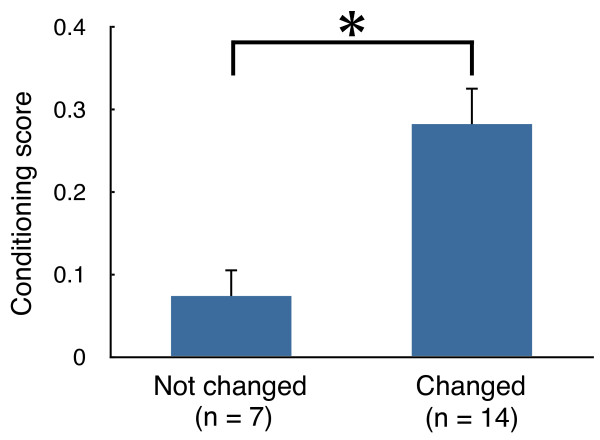
Comparison of the conditioning scores between fish with different PC responses to the CS. Conditioning scores (mean + SEM) for the fish with PCs that showed conditioning-related changes in response to the CS were greater than the scores in the fish with PCs that did not show conditioning-related changes in the response to the CS. Conditioning scores were calculated by averaging the conditioned responses in the last ten trials of the acquisition sessions. * denotes a significant difference (Mann-Whitney U test, p < 0.01).